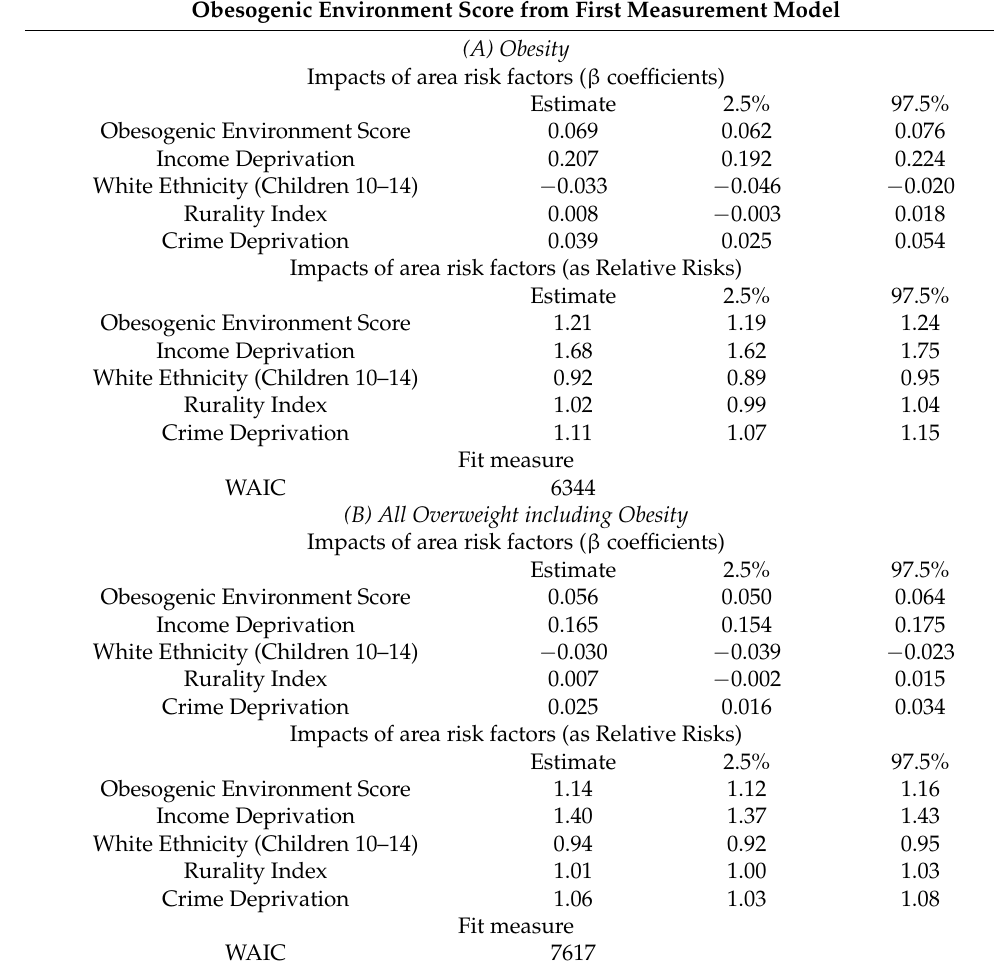
Table 3. Child Obesity and Overweight Regressions. Obesogenicity First Measurement Model. Obesogenic Environment Score from First Measurement